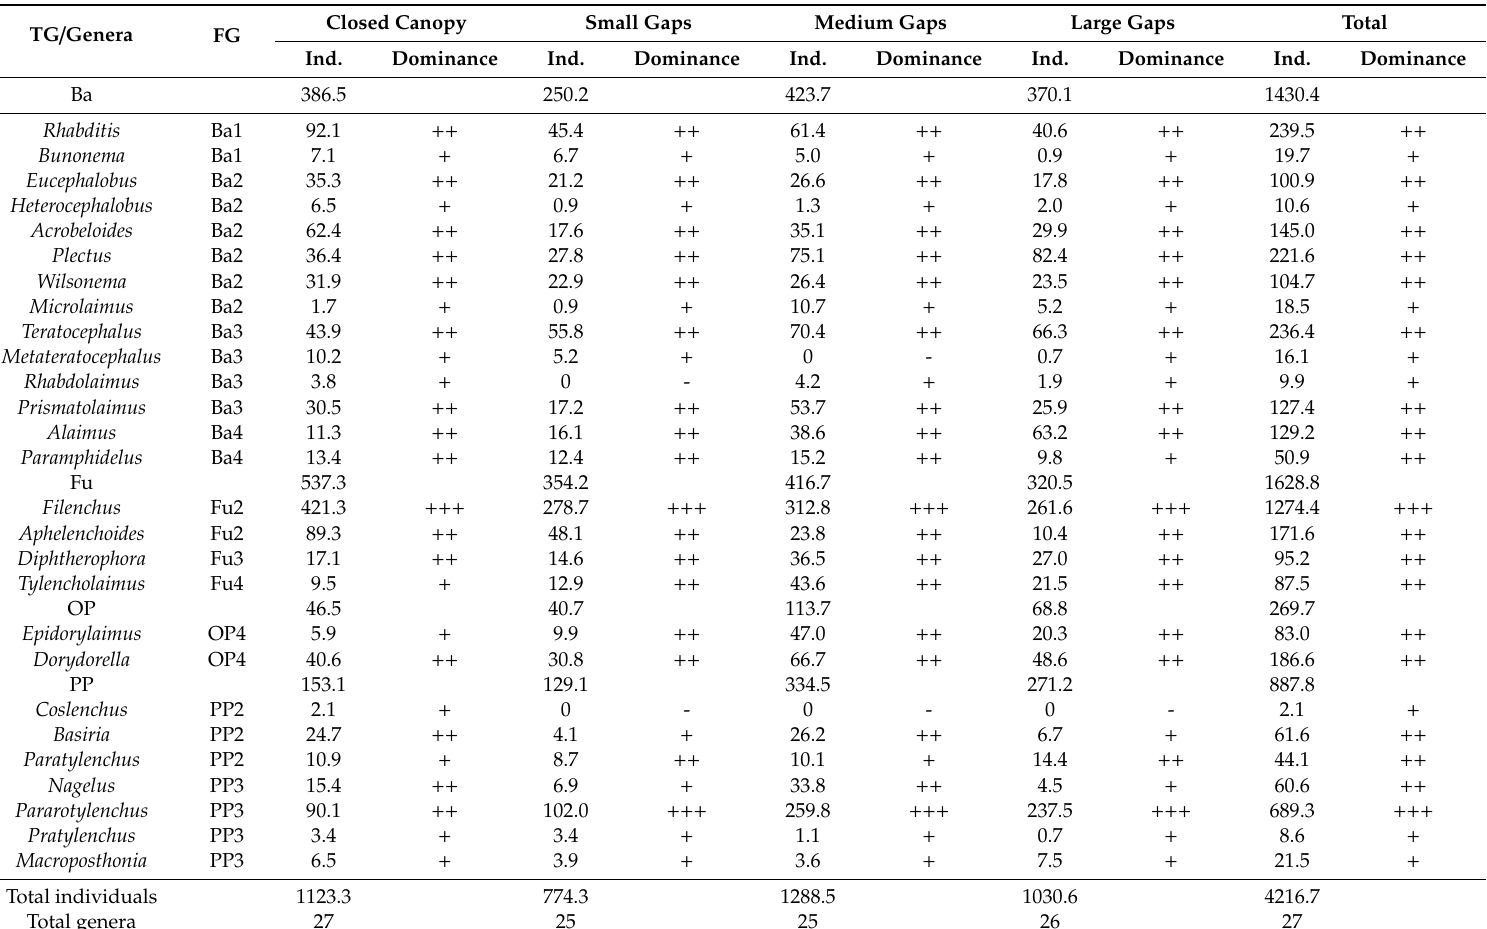
Table 2. Composition and abundance (ind. · 100 g − 1 dry soil) of soil nematodes in the closed canopy and three types of forest gaps. TG /